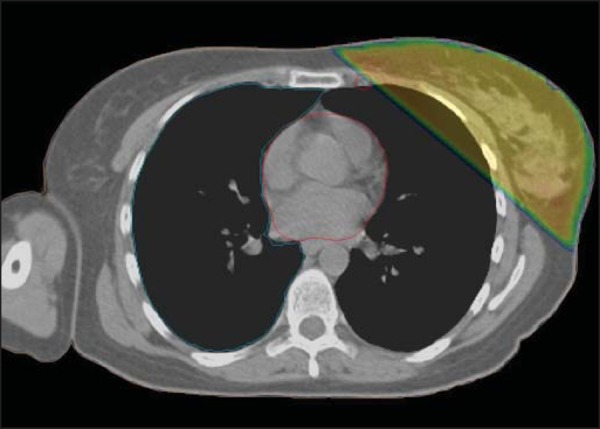
Internal mammary lymph nodes (red) and isodose curve (45 Gy; green).